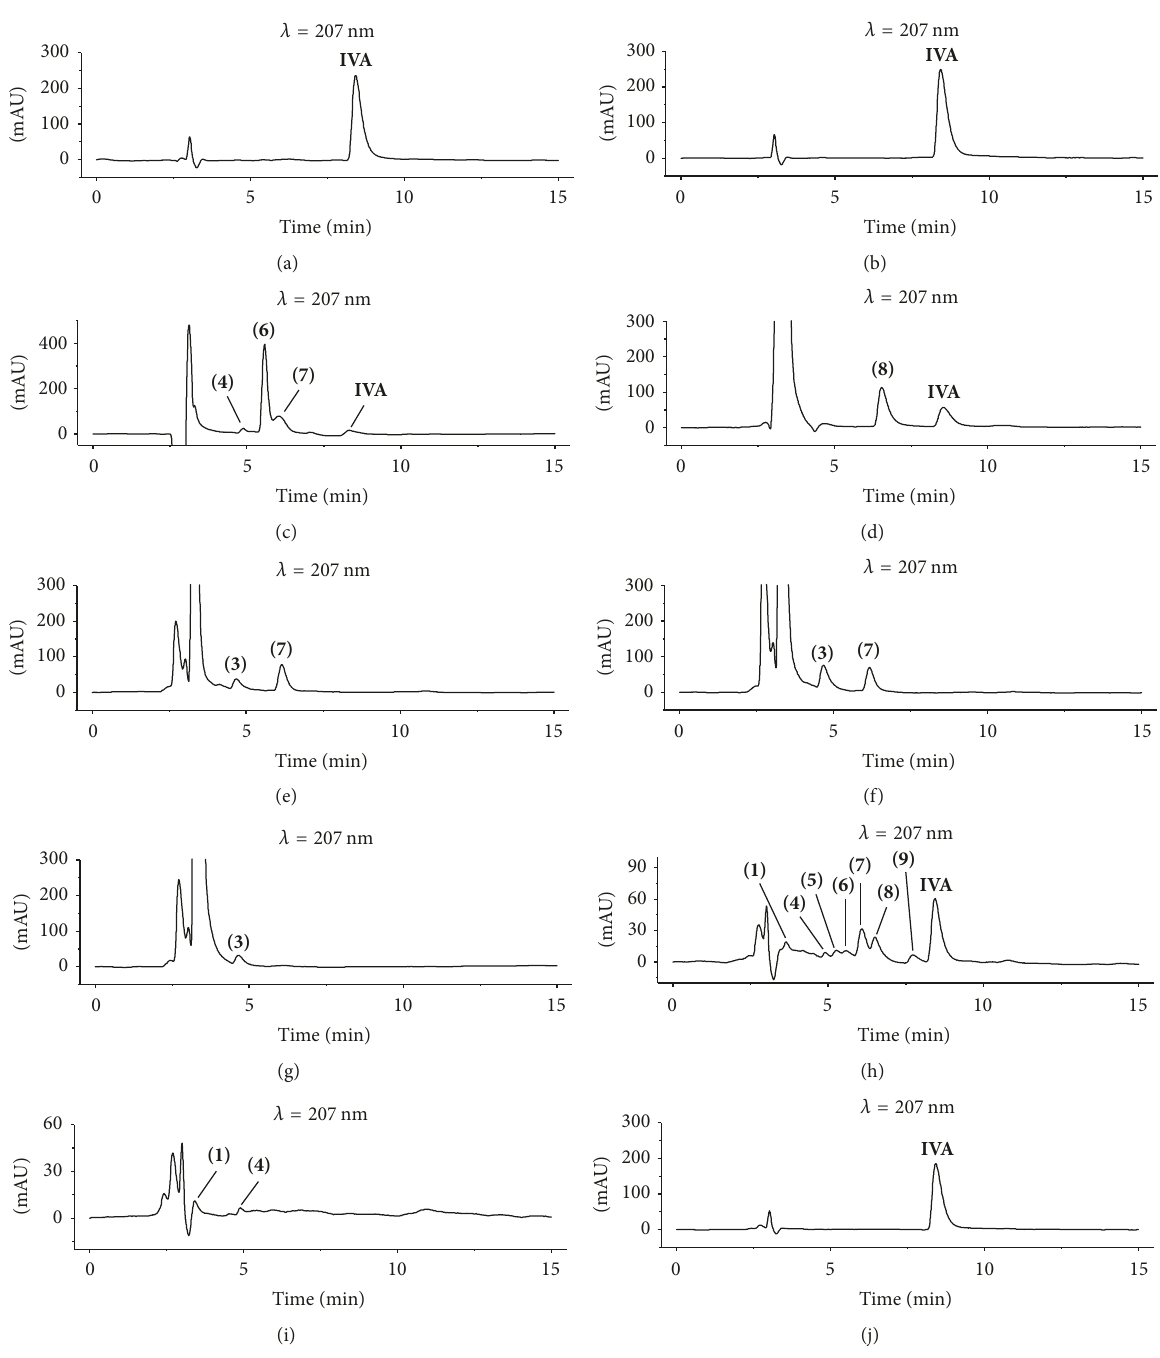
𝑆/𝑁 ratio is consistent with the standard deviation of the 𝑦 -intercept of the calibration curve method, since both give similar